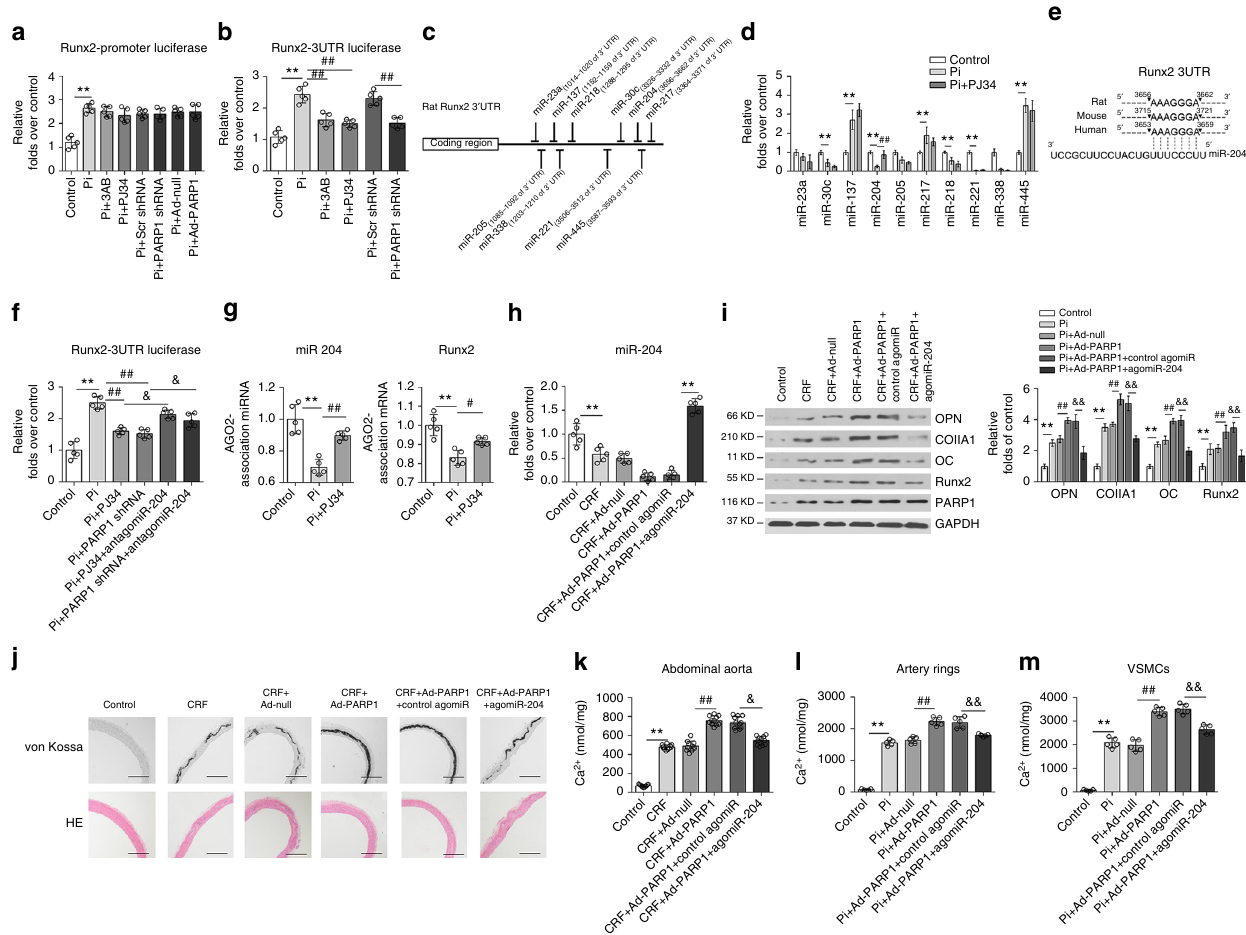
Fig. 5 miR-204 mediates the regulation of PARP1 on Runx2. a A7r5 cells were transfected with the Runx2 promoter, along with 3AB, PJ34 or Scr shRNA and PARP1 shRNA treatments. The luciferase activity was analyzed. ( n = 5 per group). b The Runx2-3 ′ UTR plasmid was transiently transfected into A7r5 cells before stimulation as indicated. The luciferase reporter assay was analyzed. ( n = 5 per group). c Seed regions of predicted Runx2-targeting miRNAs. d Selected miRNA expression levels in calci fi ed VSMCs were analyzed by qRT-PCR assays. ( n = 5 per group). e The putative miR-204 sequence present in Runx2 is conserved across different species. f A7r5 cells were co-transfected with the Runx2-3 ′ UTR plasmid and miR-204 antagomir, and then treated with high Pi in the absence or presence of PARP inhibitor or PARP1 de fi ciency. The luciferase activity was analyzed. ( n = 5 per group). g Rat VSMCs were treated with high Pi or high Pi + PJ34 for 3 days. The binding ability of miR-204 to Runx2 3 ′ UTR in RISC complex was detected by RIP assay. h – k Rat abdominal arteries were inoculated with Ad-Null or Ad-PARP1 at three weeks after the adenine diet, and miR-204 agomir was intravenously injected through the tail vein for three consecutive days. miR-204 expression was determined by qRT-PCR ( h ). ( n = 5 per group). The expression of osteogenic genes (OPN, ColIA1, OC, and Runx2) was analyzed by western blot ( i ). ( n = 5 per group). The vascular calci fi cation was detected by von Kossa staining ( j ) and the calcium quanti fi cation ( k ). ( n = 10 – 12 per group). Scale bar, 100 μ m. l , m The aortic rings ( l ) or rVSMCs ( m ) were transfected with control or miR-204 agomir together with Ad-Null or Ad-PARP1, and exposed to the osteogenic medium for 14 days. The calci fi cation was determined by the calcium assay respectively ( n = 5 per group). Statistical signi fi cance was assessed using one-way ANOVA for multiple comparison and is presented as follows: ** P < 0.01, # P < 0.05, ## P < 0.01, & P < 0.05 and && P < 0.01. All values are means± S.D. Source data are provided as a Source Data fi